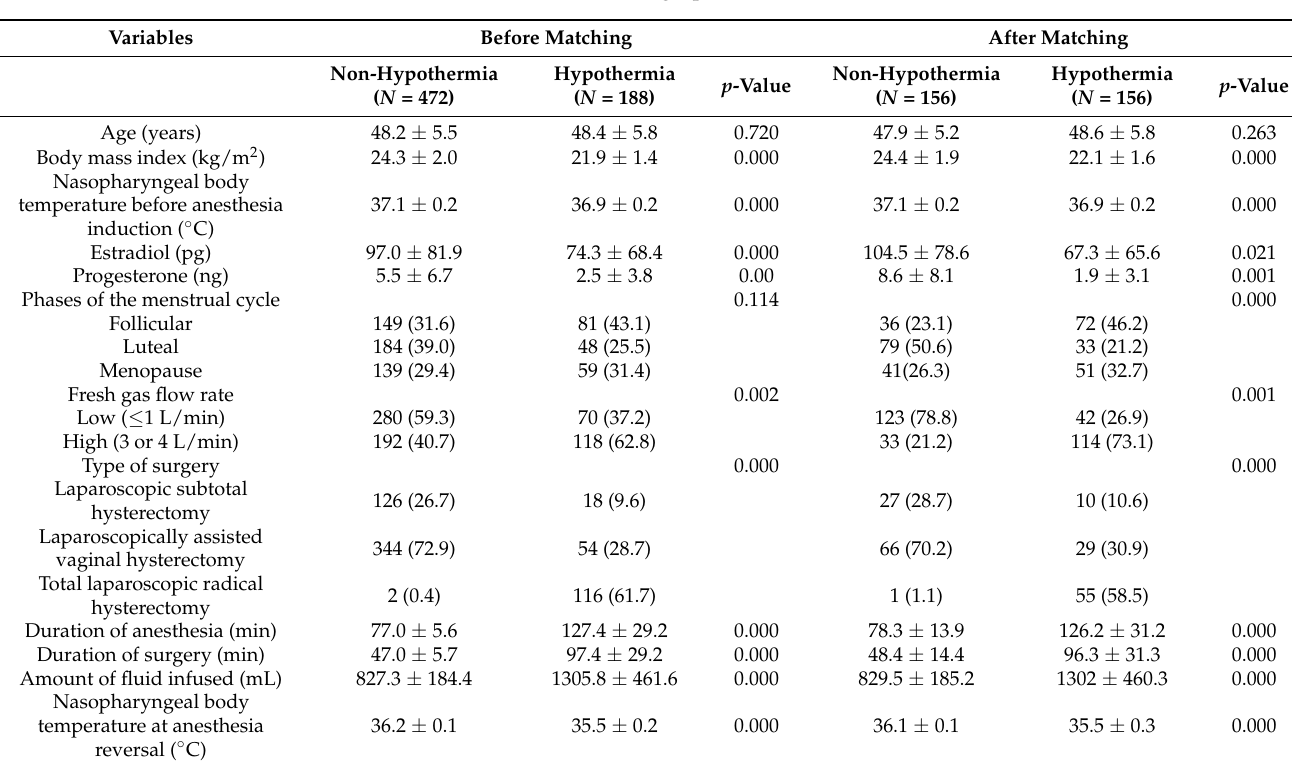
Table 1. Demographic